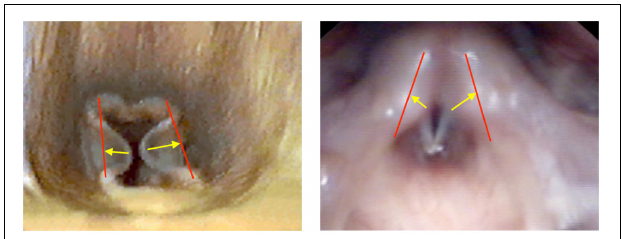
FIGURE 2 | Endoscopic photographic images during exercise of: (left) marked medial deviation of the aryepiglottic folds in an equine. (Right) Grade 3 supraglottic EILO in a human. Red lines denote expected line of aryepiglottic fold in a normal subject. Yellow arrows denote degree of collapse to